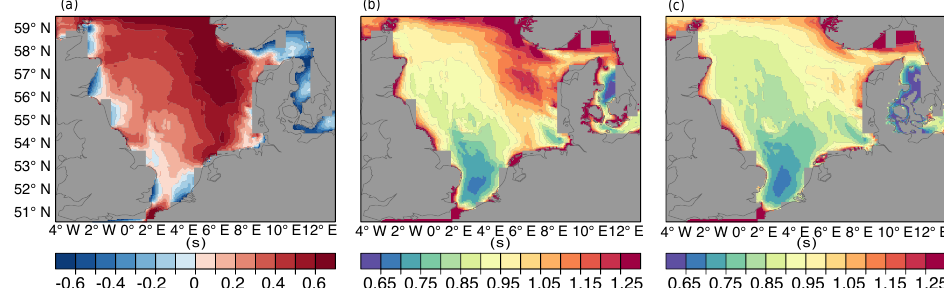
Figure 8. Spatial distribution (in seconds)of bias (a) , root mean square error (b) and standard deviation of the error (c) , between the mean wave period between from the coastDat2 hindcast and ERA-Interim reanalysis for the period 1980–2014.